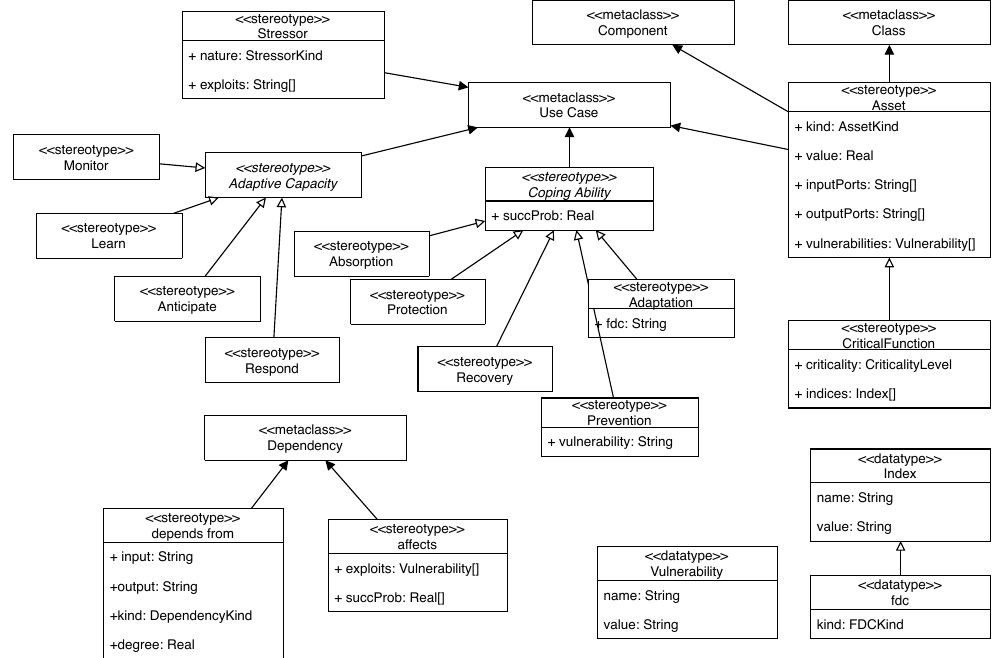
Figure 7. The cyber-resilience UML Profile.